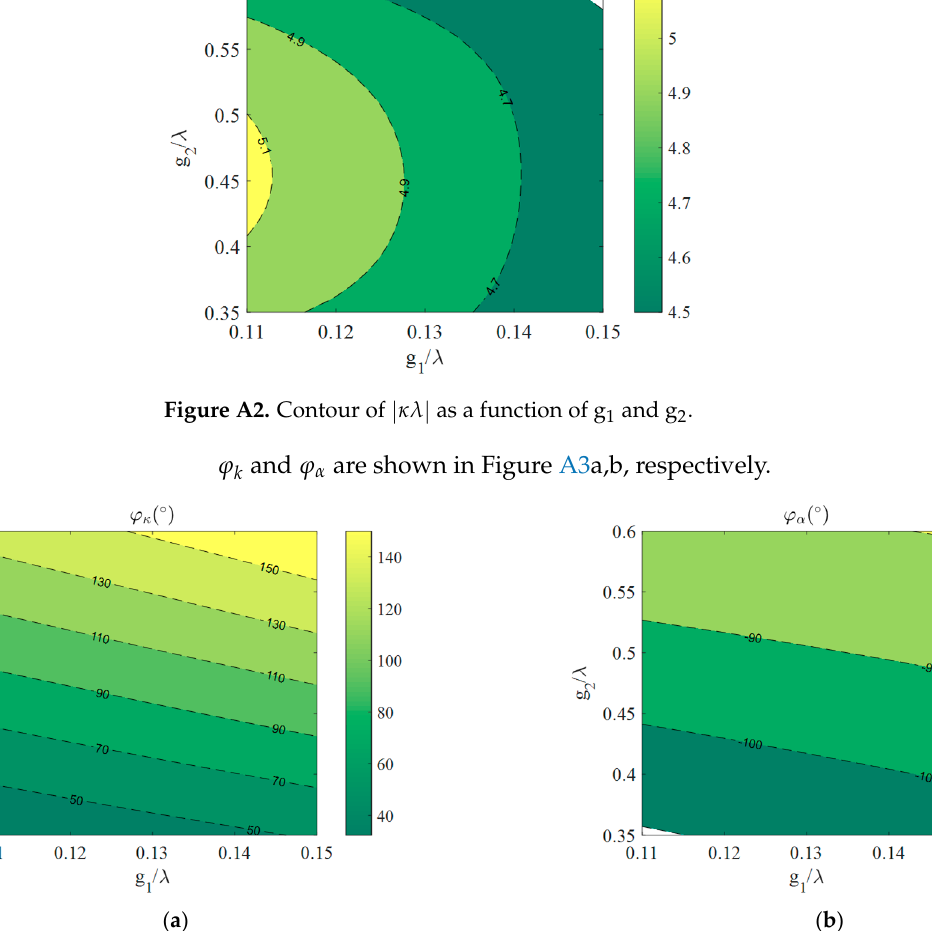
Figure A4. Contour of the transduction coefficient as a function of g 1 and g 2 . We processed the unidirectional angle θ with θ = θ − 360 so that it is in the range of − 180 ° to 180 ° , shown in Figure A5. Figure A5. Contour of θ as a function of g 1 and g 2 .